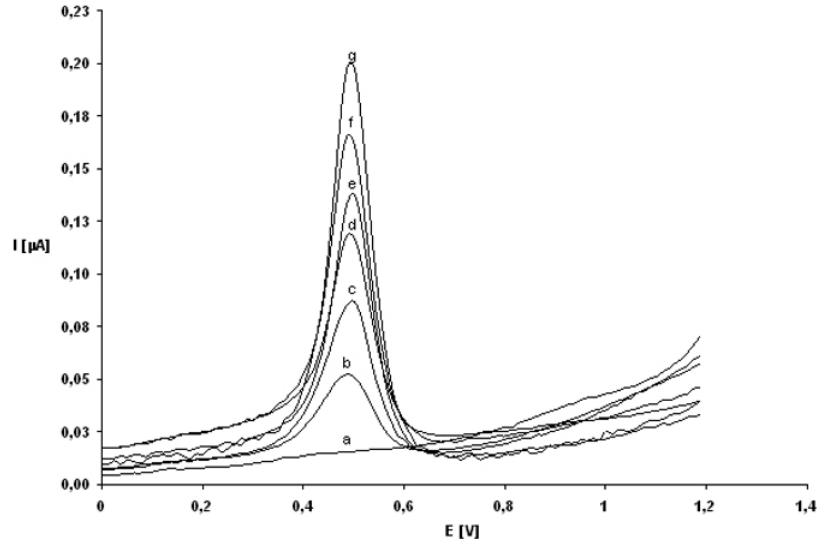
Figure 4. Differential pulse voltammograms of triclosan in Britton-Robinson buffer of pH 9.9: a) blank measurement, b) 17.3 µM, c) 34.5 µM, d) 51.8 µM, e) 69.1 µM, f) 86.3 µM, g) 103.6 µM. Scan rate: 50 mV s -1